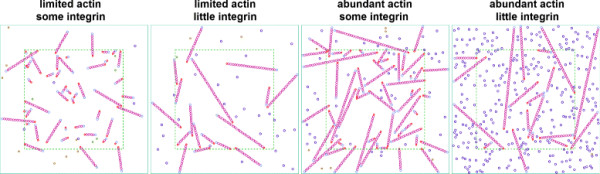
Simulation illustration with small single surface structure with a fixed amount of actin and no limitation of filament orientation or severing (i.e., no cofilin). Magenta circles represent actin entities with other entities bound at both ends (i.e., in filament chains), light blue circles are actins at filement ends (i.e., occupied pointed end, free barbed end), Purple/dark blue circles: free actin, smaller red circles: integrins at start of filament, dark green and brown circles, free integrin on and outside of a surface structure. Surface structure boundaries marked by green dashed lines. Too little actin can lead to relatively short filaments (left), too little integrin and abundant actin to a few long filaments and many free actins that have no room to bind to a filament (right). Filament “growth” can also be impeded by the two-dimensional approach where filament crossing or bending is not allowed (center right; note also several free actins trapped in regions bound by different filament segments).